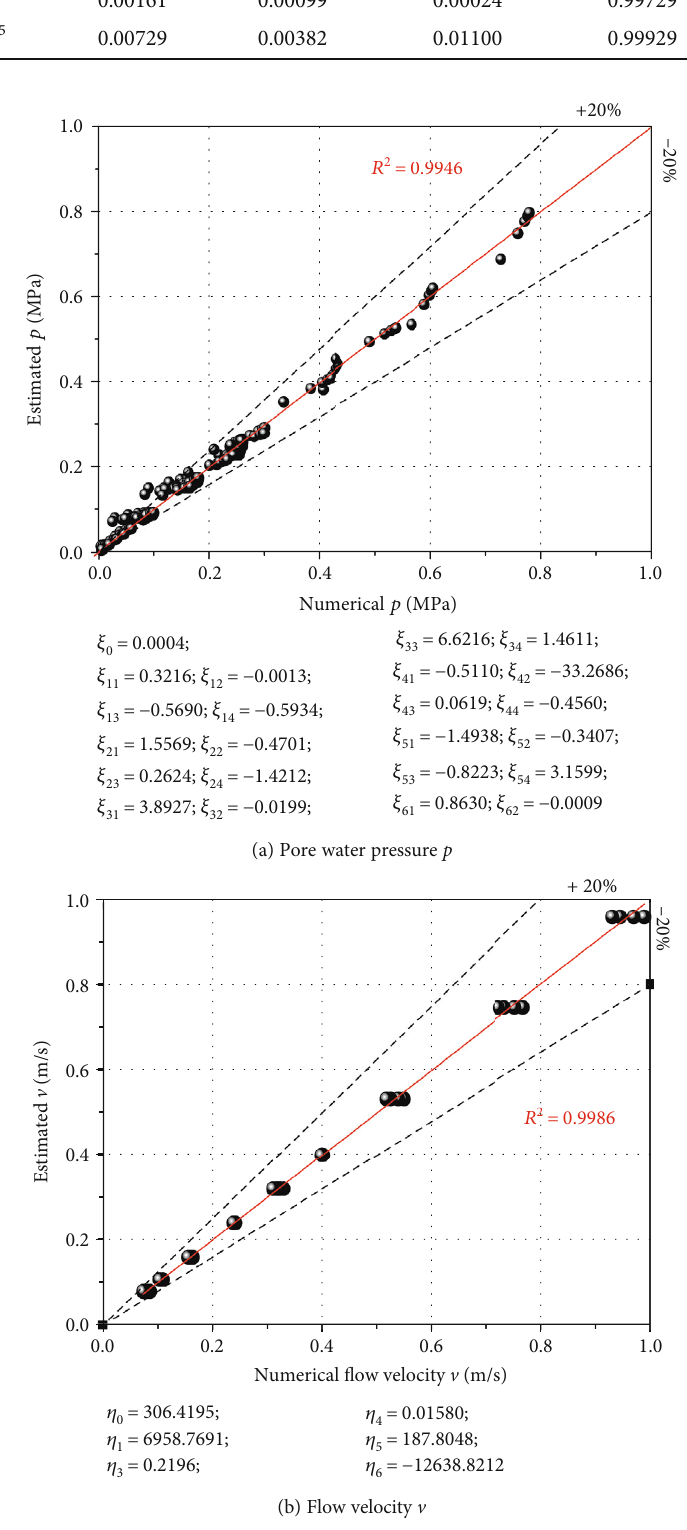
Figure 16: Correlation between the calculated values of the genetic algorithm and numerical